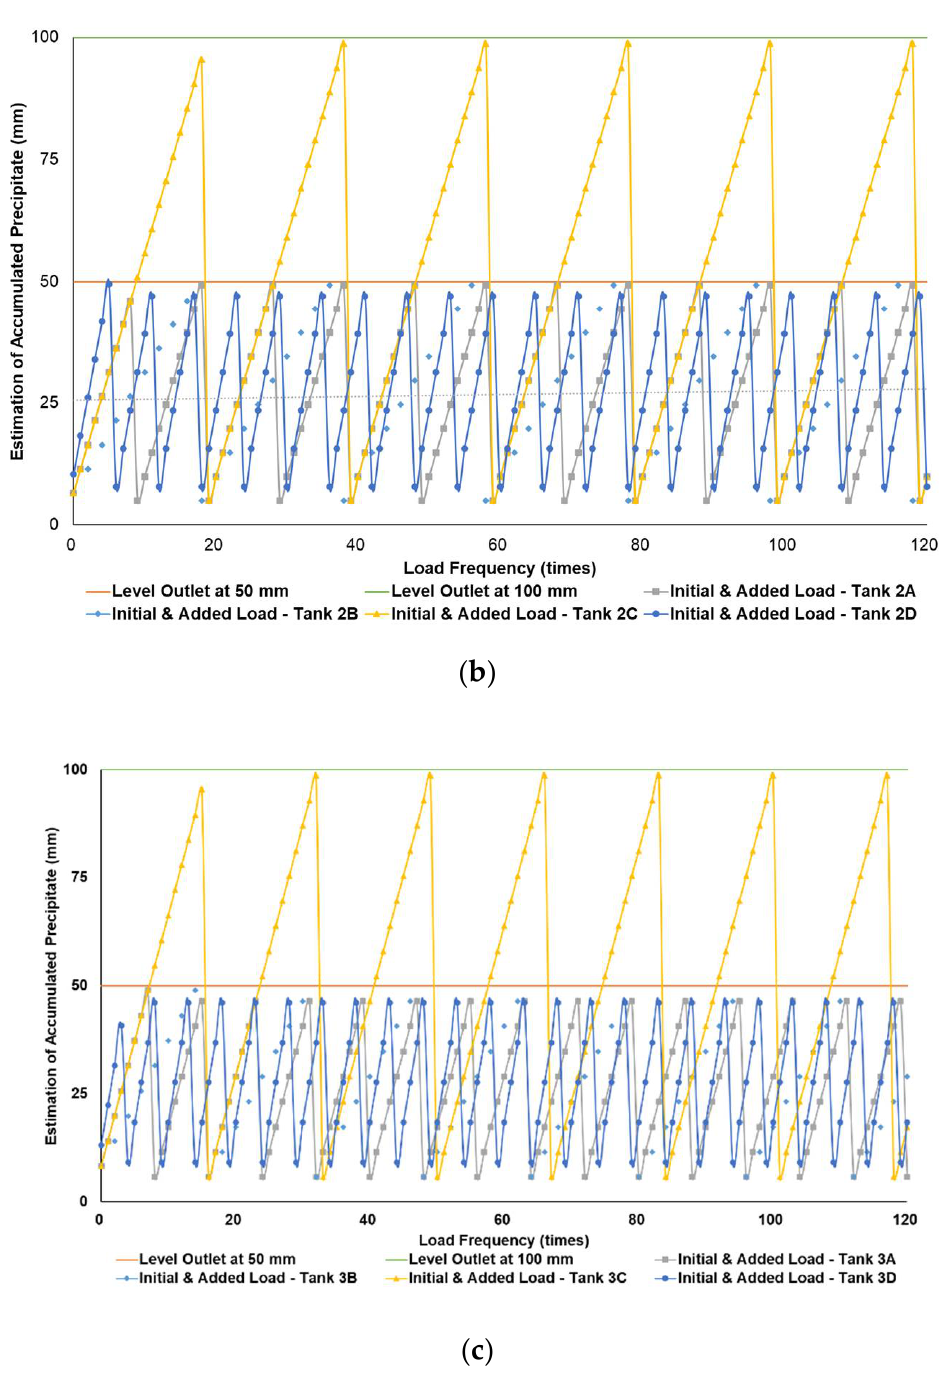
Figure 4. Schedule simulation for sludge removal from the storage tank of B20 fuel blended from B100 with monoglyceride content of 0.623%-mass. The tank volume is ( a ) 50, ( b ) 100, and ( c ) 200 m 3 . Figure 5a–c simulates the removal schedule of sludge accumulated from B20 fuel obtained from the market in different tank storage volumes.